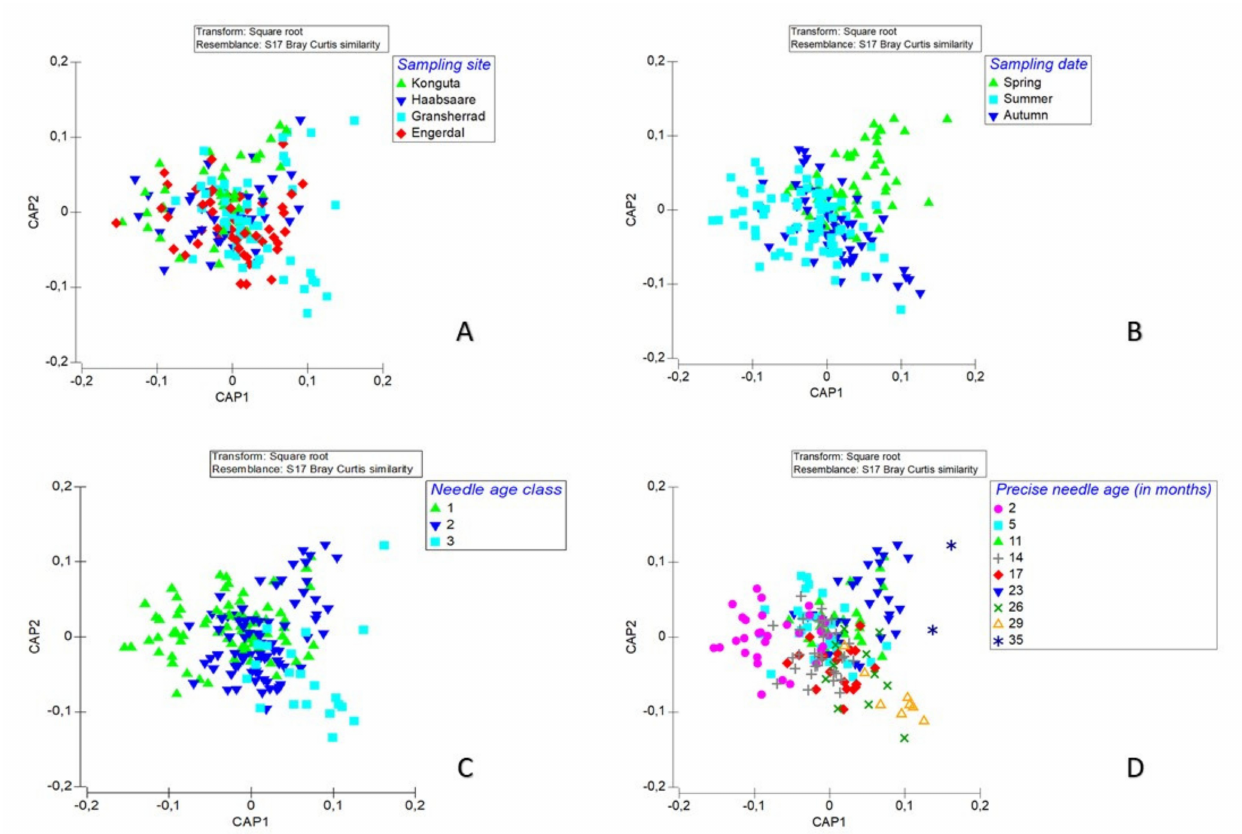
Figure 5. Canonical analysis of principal coordinates (CAP) of differences in fungal community structure between the four investigated sampling sites in northern Europe (two in Estonia, two in Norway); ( A ) three sampling dates ( B ), three needle-age classes ( C ) and precise needle ages in months ( D